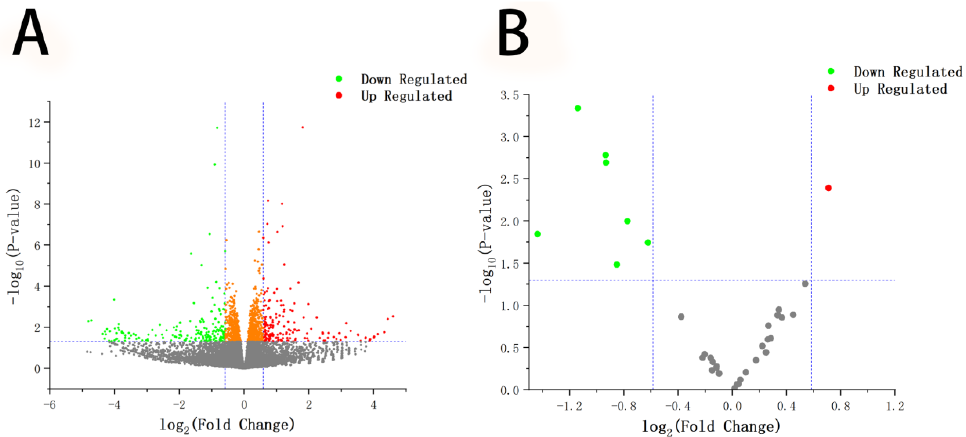
Figure 4. Volcanic map of differentially expressed mRNA and miRNA. The volcanic map shows the number of differentially expressed genes and miRNAs in the control and test groups. Red and green represent the upregulated and downregulated genes and miRNAs.